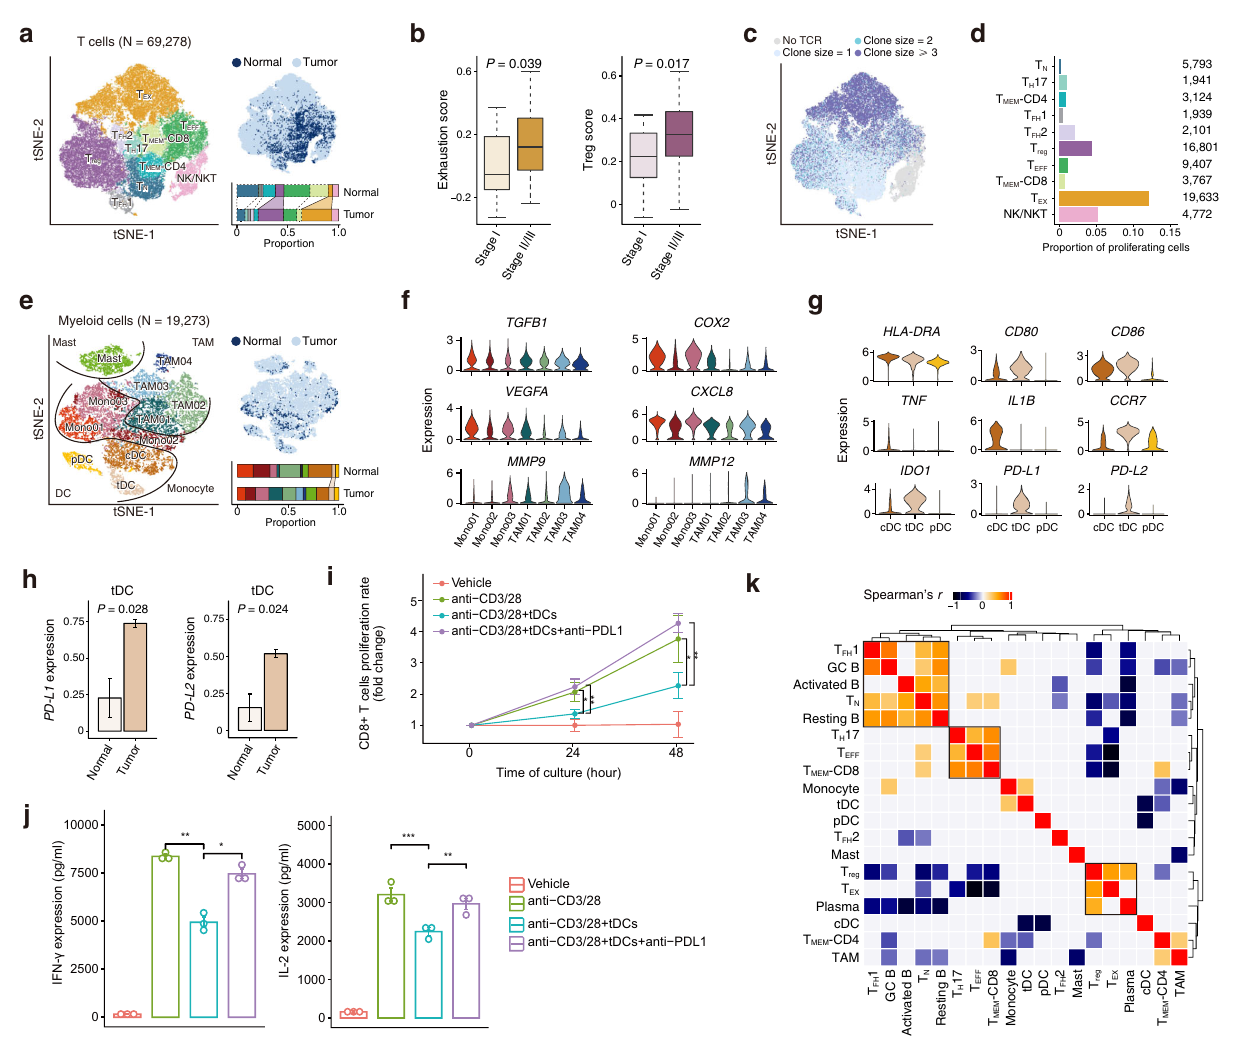
Fig. 4 Characterization of immunosuppressive ESCC tumor microenvironment. a tSNE plots of 69,278 T cells, colored by cell type ( left ) and tissue type ( top right ). The proportions of cell types in normal and tumor tissues are shown on the bottom right (colors as in the left panel). See Fig. 1b legend for the line indications. b Boxplots showing exhaustion score ( left ) and Treg score ( right ) of T cells are differentially distributed in patients at stage I (N = 16) and stage II/III (N = 44). P values of two-sided Wilcoxon test are shown. Boxplots show the median (central line), the 25 – 75% interquartile range (IQR) (box limits), the ±1.5 times IQR (Tukey whiskers), and all data points, among which the lowest and the highest points indicate minimal and maximal values, respectively. c tSNE plot of T cells colored by clone size. d Bar plot showing fractions of proliferating cells in each T cell subtype. The cell numbers of T cell subtypes are labeled on the right. e tSNE plots of 19,273 myeloid cells, colored by cell type ( left ) and tissue type ( top right ). The proportions of cell types in normal and tumor tissues are shown on the bottom right (colors as in the left panel). See Fig. 1b legend for the line indications. f Violin plots showing the expression distribution of selected genes involved in immune suppression and angiogenesis in the monocyte and TAM clusters. g Violin plots showing the expression distribution of selected genes involved in DC maturation and immunosuppression in the three DC clusters. h Boxplots showing the expression levels of PD-L1 and PD-L2 in tDC are higher in tumor tissues ( N = 60) compare with normal tissues ( N = 4; two-sided Student ’ s t -test). The data presented as mean ± SEM. i , j 100,000 autologous CD8 + T cells isolated from human patients ’ peripheral blood and tDCs were co-cultured in a 96-well plate at a ratio of 10:1 with Human T-Activator CD3/CD28. Anti-PD-L1 was administered at 100 μ g/ml. T cell number was counted by hemocytometer at day 1 and day 2 ( i ). IL-2 and IFN- γ levels of the coculture supernatant at day 2 were measured by BD Cytometric Bead Array (CBA) kit ( j ). In ( i , j ), P values are derived from two-sided Wilcoxon test; * P < 0.05, ** P < 0.01, *** P < 0.001. The data presented as mean ± SD and mean ± SEM in ( i ) and ( j ), respectively. Data in ( i , j ) are representative of three independent experiments for each group. k Clustered heatmap showing two-sided Spearman correlation coef fi cients between proportions of immune cell subtypes in tumor samples. P < 0.05 is used as the cutoff